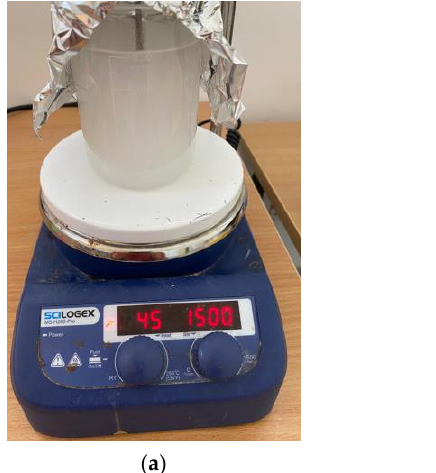
Figure 1. ( a ) Stirring setup and ( b ) settled microcapsules.